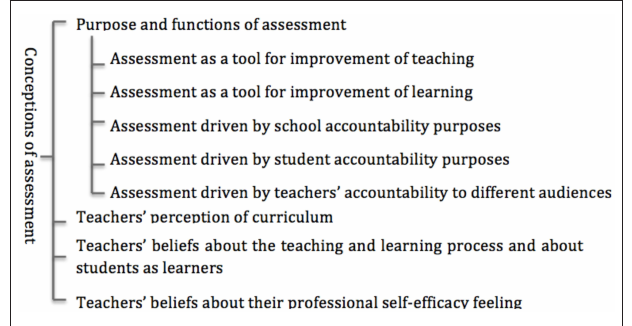
FIGURE 1 | Framework of conceptions of